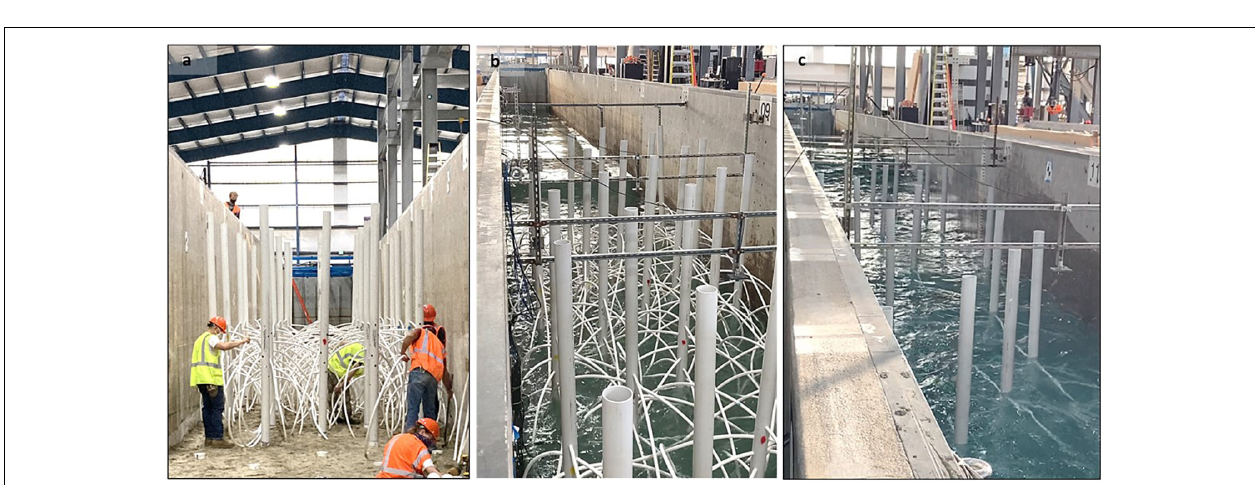
FIGURE 3 | (a) Plan view of large wave flume showing baseline (BL) configuration. (b,c) Detailed view of mangrove test section showing mangrove locations in (b) high-density (HD) and (c) low-density (LD) configurations.